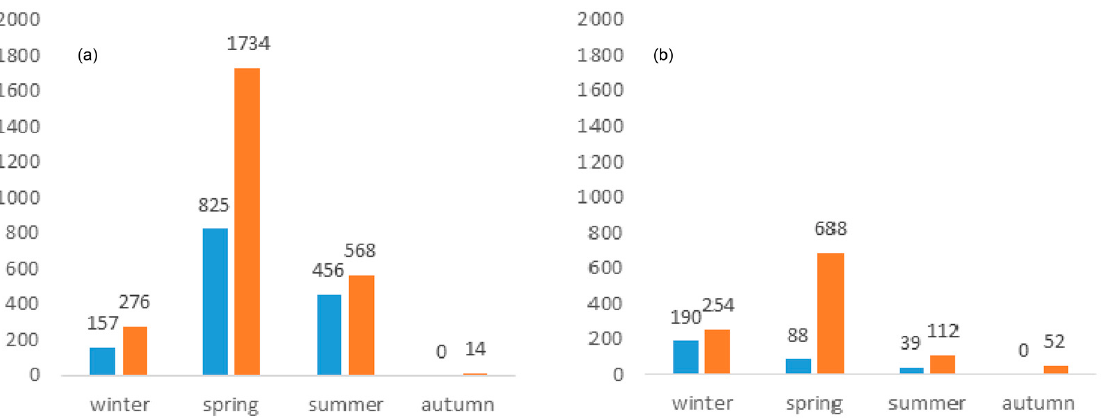
Figure 8. Seasonal variability of total plume areas (km 2 ) from the Mzymta ( a ) and Sochi ( b ) rivers in 2020–2021.